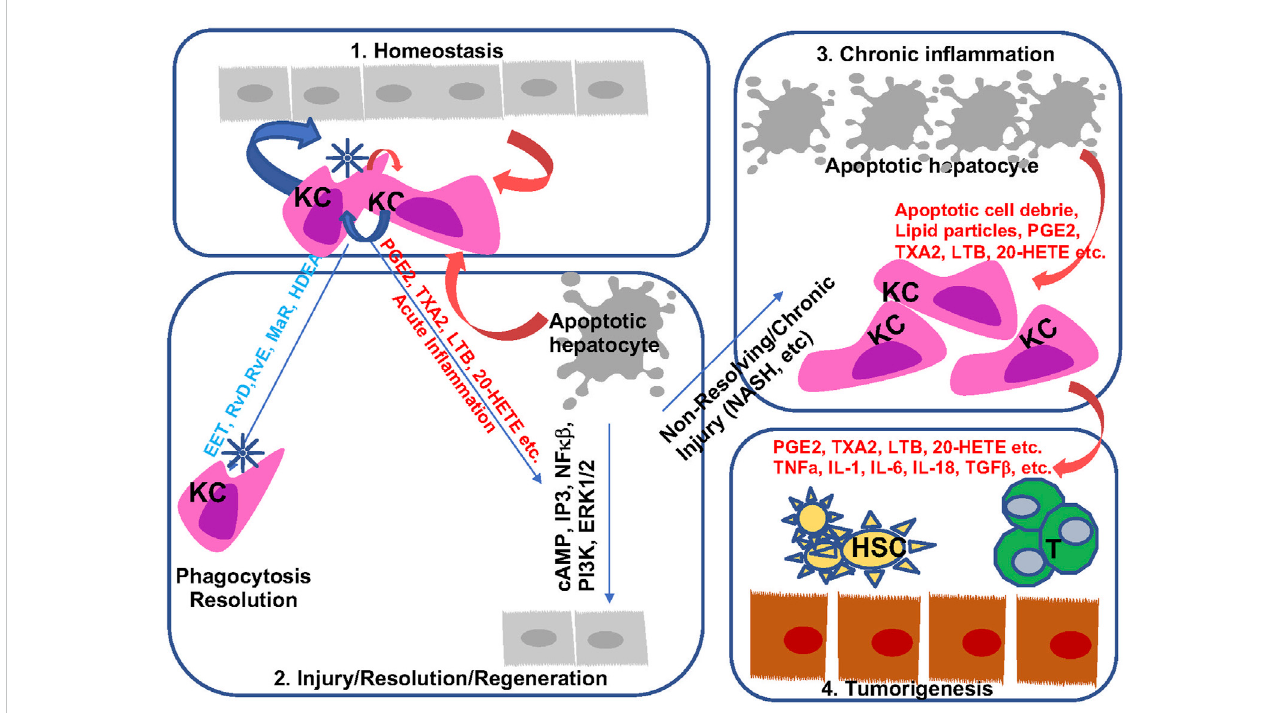
Bioactive lipids and progression of liver disease. During homeostasis, hepatocytes and macrophages produce a balanced levels of pro- and anti- in fl ammatory lipid species to maintain liver immune environment (Sung et al., 2021) . In response to acute injury, apoptotic cell debris alters macrophage polarization to produce both pro- and anti-in fl ammatory lipids. These lipids are involved in the resolution of in fl ammation as well as regeneration of hepatocytes (Singal et al., 2020). During chronic in fl ammation when sustained injury is present such as those presented with steatohepatitis, proin fl ammatory eicosanoids together with apoptotic cell debris sustain injury by polarizing macrophage towards a M2 phenotype (Sanyal et al., 2010). In addition, downregulation of resolvins permits chronic in fl ammation with reduced phagocytic activities from macrophages. The mitogenic signal from the proin fl ammatory eicosanoids and pro-tumor cytokines present a pro-tumor immune microenvironment to promote the progression from chronic in fl ammation to HCC (Kudo, 2017). They also interact with other cells (HSC an T cells as example) in the liver to regulate liver disease